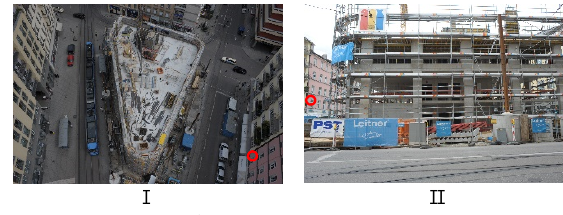
Figure 5. Example for two images taken on the construction site. Image I is taken from the crane. The red circles show a control point.